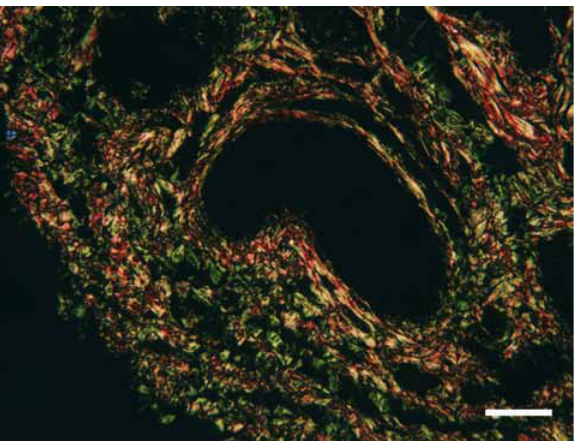
Figure 6 - Collagen arrangement in the tunica adventitia of the DAP of rabbits from the diabetic group. Sections were stained with Picro Sirius red stain, and images were taken using polarized light at 400x magnification. Scale bar: